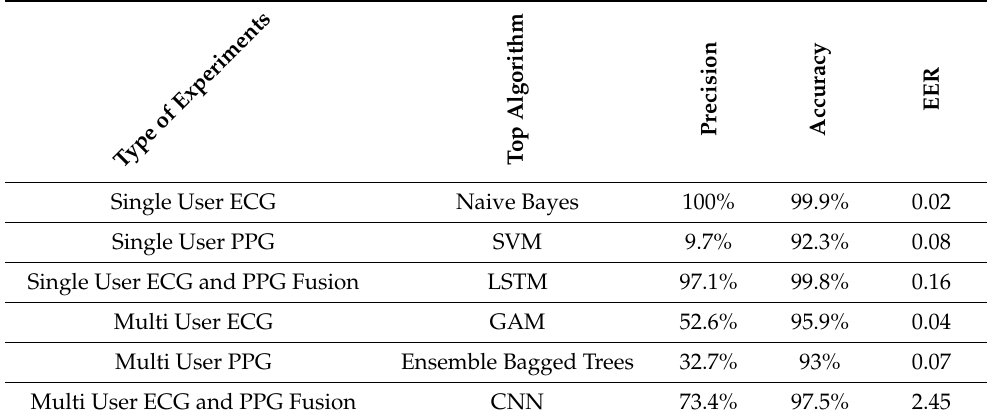
Table 10. Summary of the Biometric Experiments.